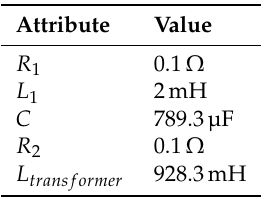
Figure 1. Averaged inverter model with controls. Table 1. Averaged inverter example